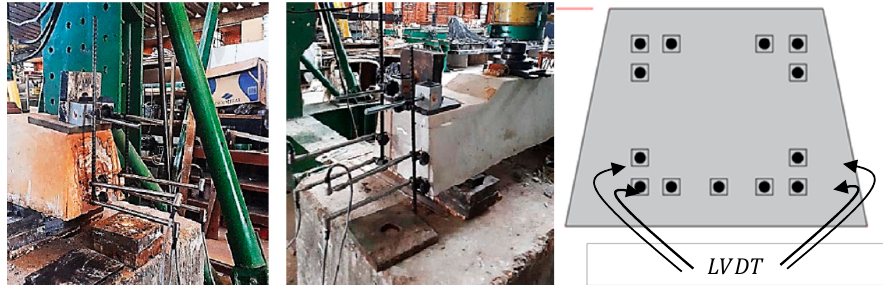
Figure 4. Position of wires tested with LVDT (Linear Variable Differential Transformer) to obtain the wire displacements, experimental test in Structures Laboratory.